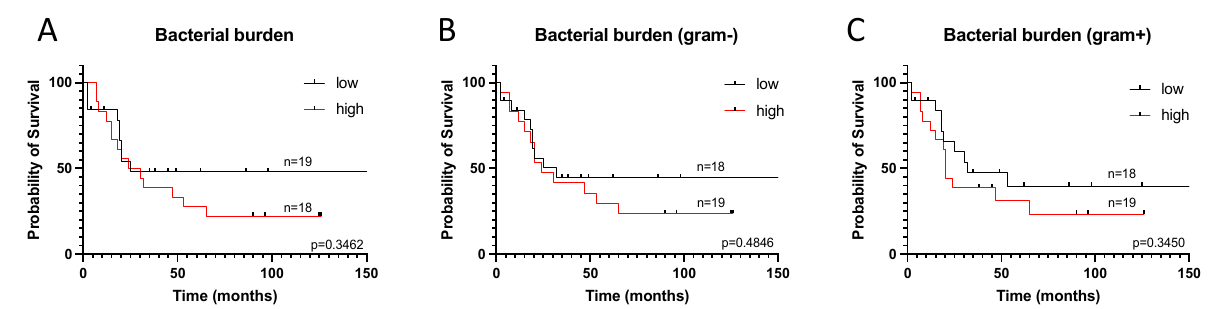
Figure 5. Survival of patients with ESCC versus total bacterial burden ( A ), Gram-negative bacterial burden ( B ) and Gram-positive bacterial burden ( C ). The differences were not statistically significant.